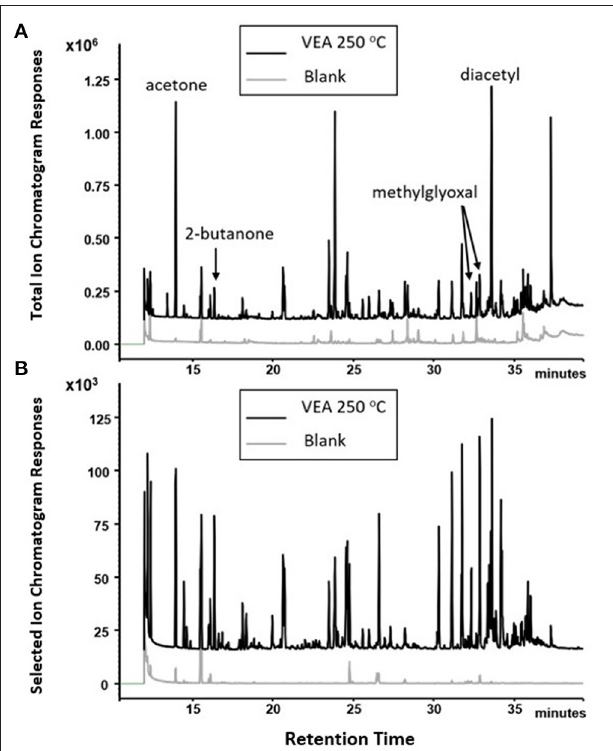
FIGURE 7 | PFBHA derivatization of carbonyls yielded the identification of four chemical emissions of VEA at 250 ◦ C: acetone, 2-butanone, methylglyoxal, and diacetyl. (A) , total ion current chromatogram; (B) , 181.0 ion extracted